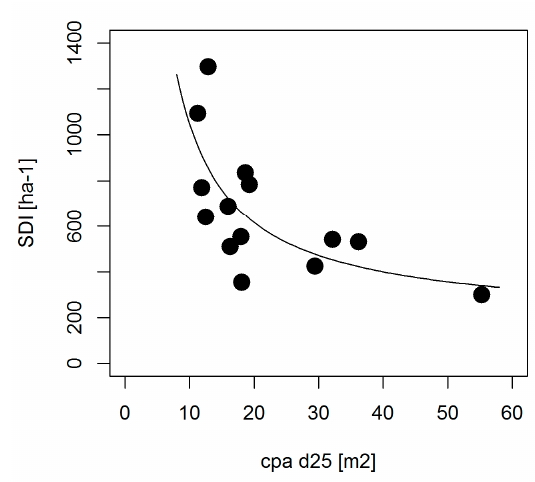
Figure 14. The reciprocal relationship between SDI and crown projection area for stands with dq = 25 cm quadratic mean stem diameter for the 14 common tree species. Data from long-term experiments with both tree crown measurements and stand inventory. Regression analysis yielded SDI = 8637.4 + 183.4 × ( 1/cpa ) for the decrease of stand density, SDI, with increasing crown projection area, cpa. (see Table 1, model 8).